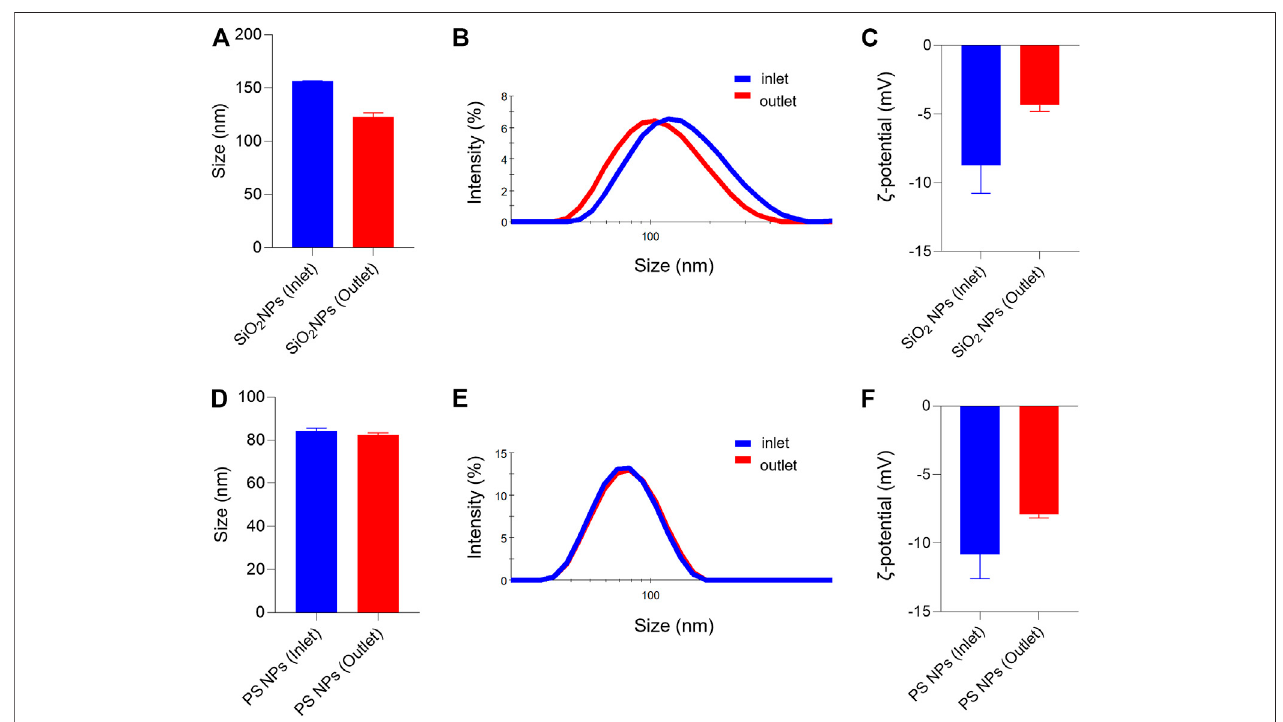
FIGURE 2 | Hydrodynamic diameter and surface charge ( ζ -potential) of SiO 2 NPs and PS NPs collected from inlet and outlet reservoirs of the micro fl uidic device (A – C) SiO 2 NPs were evaluated at 2 h of exposure (D – F) PS NPs were evaluated after 1 h of exposure. The hydrodynamic diameter of the SiO 2 NPs was: D h (inlet) (cid:2) 156 ± 0.5, and D h (outlet) (cid:2) 123 ± 4; and for the PS NPs: D h (inlet) (cid:2) 84 ± 1.3; and D h (outlet) (cid:2) 82 ± 1.0.